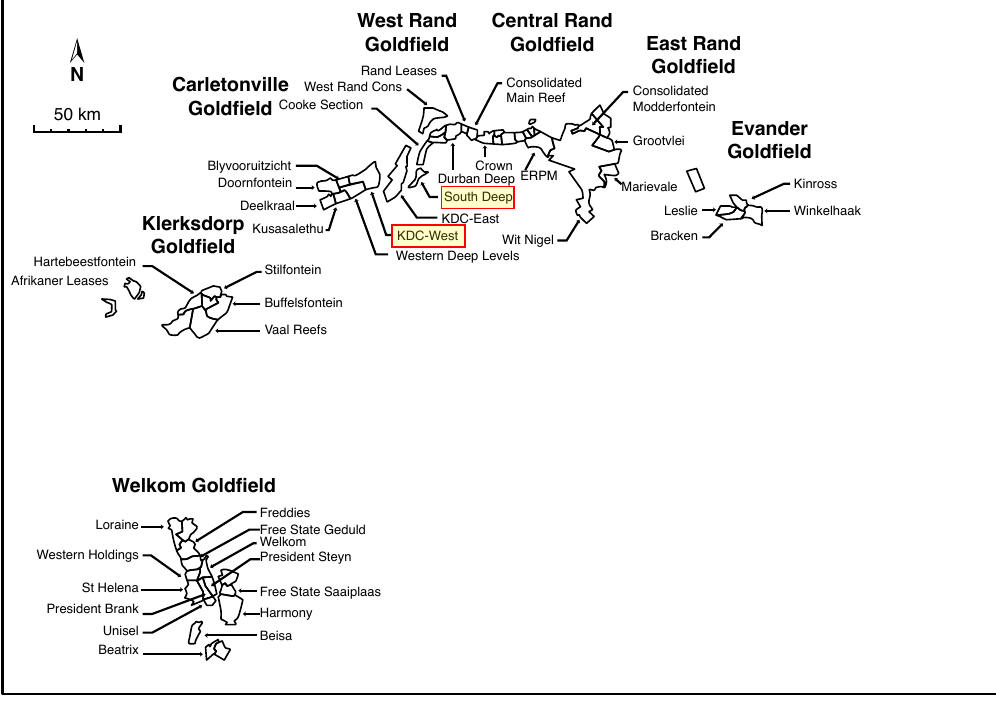
Figure 3. Location of the Witwatersrand gold mines [44], showing the localities of the South Deep and KDC (Kloof–Driefontein Complex) West